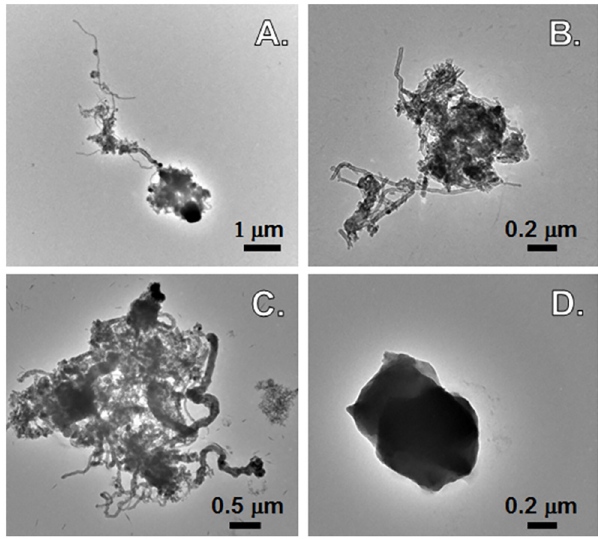
Fig 1. Transmission electron micrographs of samples collected in MWCNT facilities. TEM images of filters collected from personal breathing zone sampling showing: A, more dispersed MWCNT particles; B-C, agglomerated structures from potentially exposed groups, and D, a media blank (stored in a clean room).